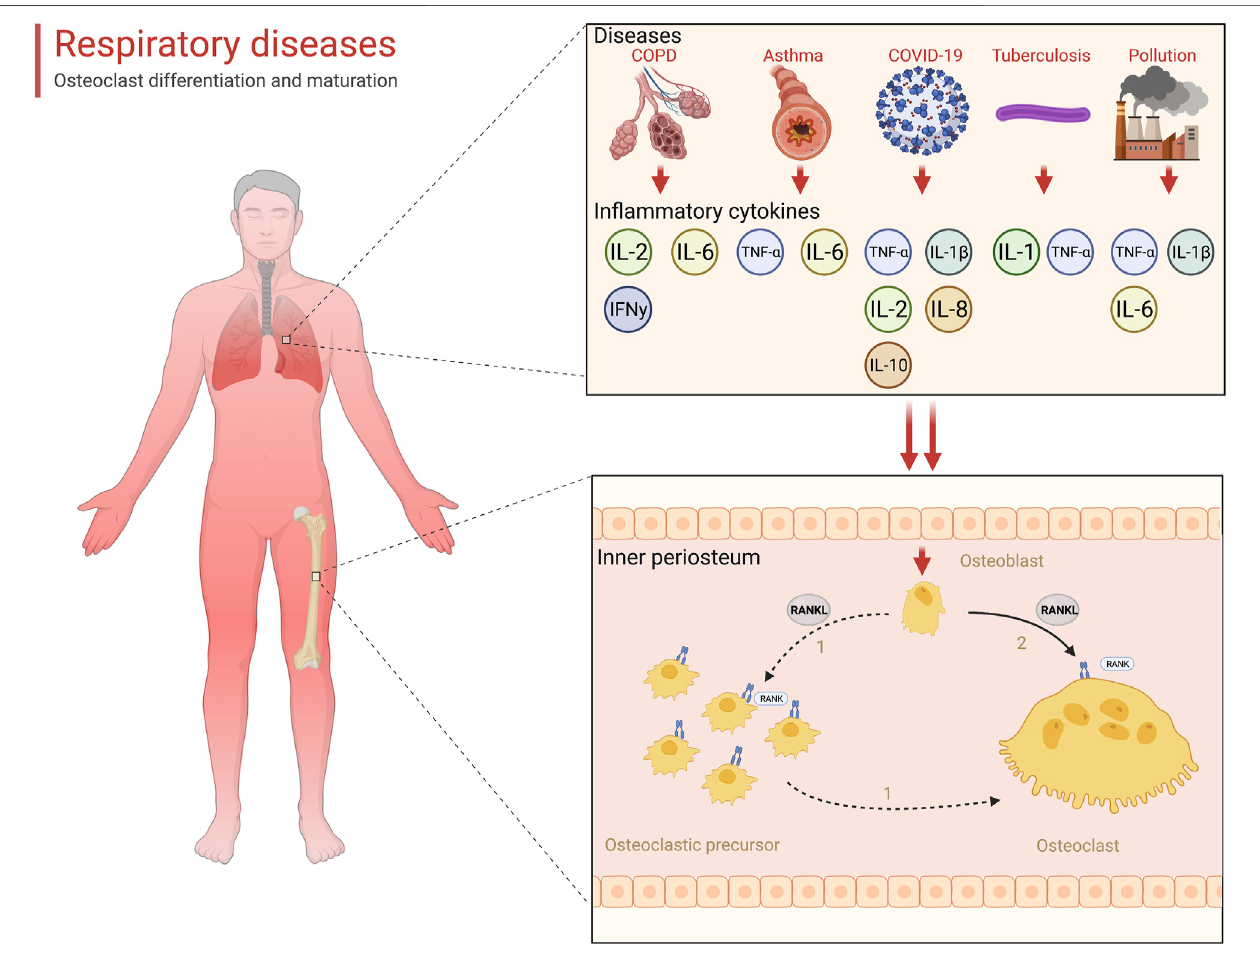
FIGURE 1 | In fl ammatory storm-mediated bone resorption with respiratory diseases (created with BioRender.com).